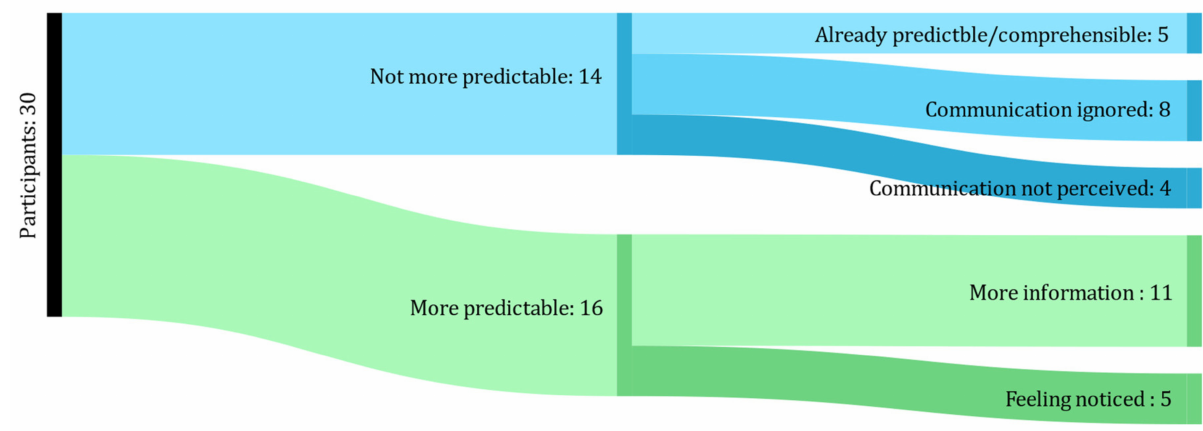
Figure 7. Frequencies of participants’ answers to interview question 3: did the external increase the comprehensibility or predictability of the AS’s behavior? Why [not]?